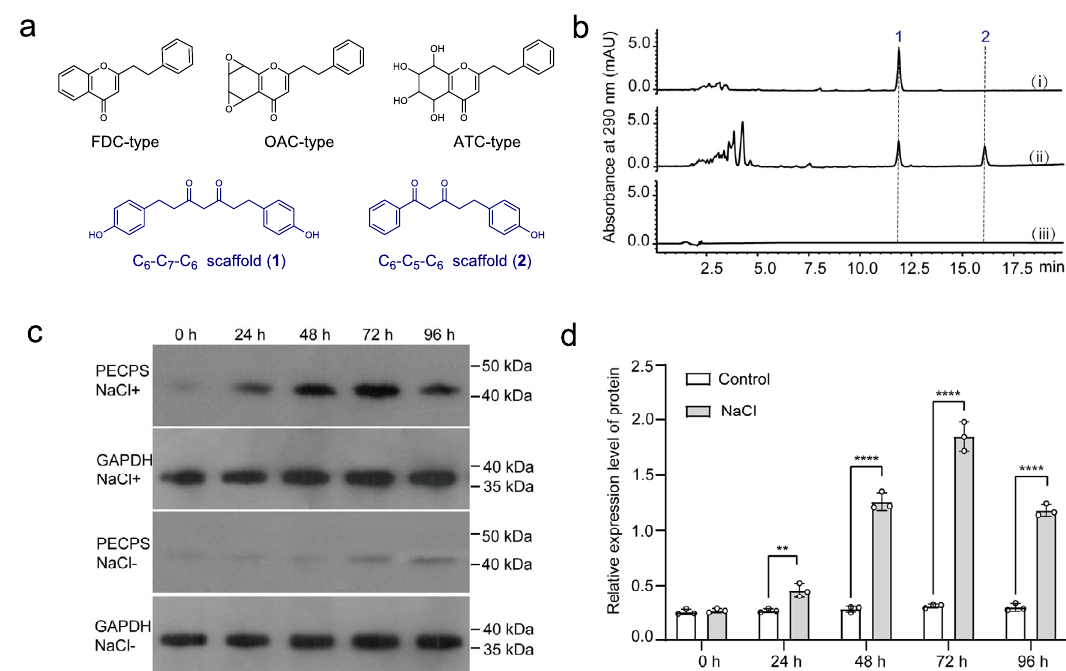
Fig. 1 Representative 2-(2-phenylethyl)chromone skeletons and the identi fi cation of PECPS. a The core structures of three groups of 2-(2-phenylethyl) chromones and enzymatic products 1 and 2 . b HPLC chromatograms for the formation of the C 6 – C 7 – C 6 scaffold of tetrahydrobisdemethoxycurcumin ( 1 ) from 4-hydroxyphenylpropionyl-CoA and malonyl-CoA by PECPS (i), The formation of the C 6 – C 5 – C 6 scaffold of 5-(4-hydroxyphenyl)-1-phenylpentane-1,3- dione ( 2 ) from benzoyl-CoA, malonyl-CoA, and 4-hydroxyphenylpropionyl-CoA by PECPS (ii) and boiled PECPS (iii). c Western blot analysis of the PECPS protein expression levels in 150 mM NaCl-treated A. sinensis calli (NaCl + ) and healthy A. sinensis calli (NaCl-) at different time points. GAPDH was used as internal reference. d Western blot quanti fi cation of the relative expression levels of PECPS by ImageJ and normalization to the protein levels of GAPDH. Data represent the mean ± SD ( n = 3). Statistical analysis was performed with unpaired two-tailed Student ’ s t-tests. Signi fi cance is shown with asterisks: **** p < 0.0001, *** p < 0.001, ** p < 0.01. Exact p -values and source data are provided in the source data fi le. Total protein was extracted from 100 mg of calli using Plant Total Protein Extraction Reagent (Invent, USA) according to the manufacturer ’ s instructions. The protein expression levels of PECPS were analyzed by Western blotting with an anti-PECPS antibody prepared in